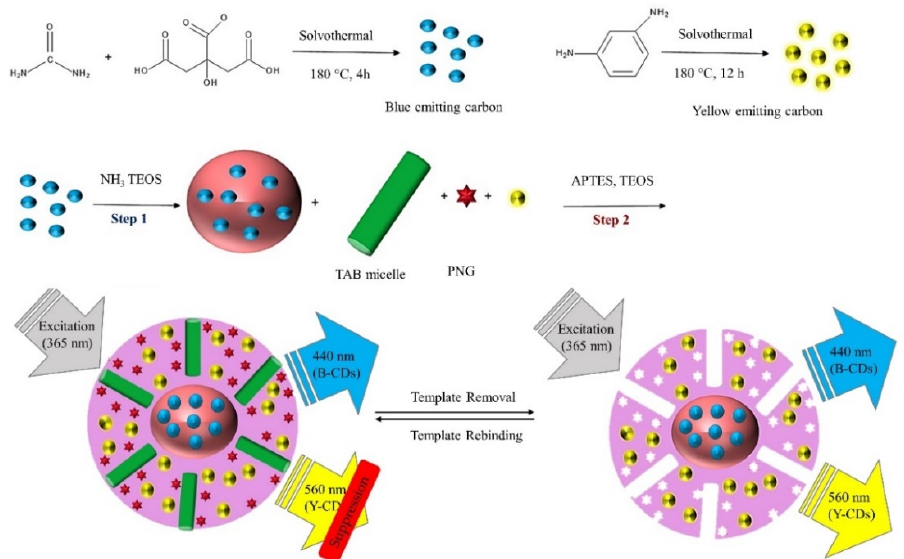
Figure 6. Schematic illustration of the fabrication process B/YCDs@mMIPs ratiometric sensor and the sensing mechanism of PNG. Reproduced with permission from [8]. Copyright 2020 Elsevier.